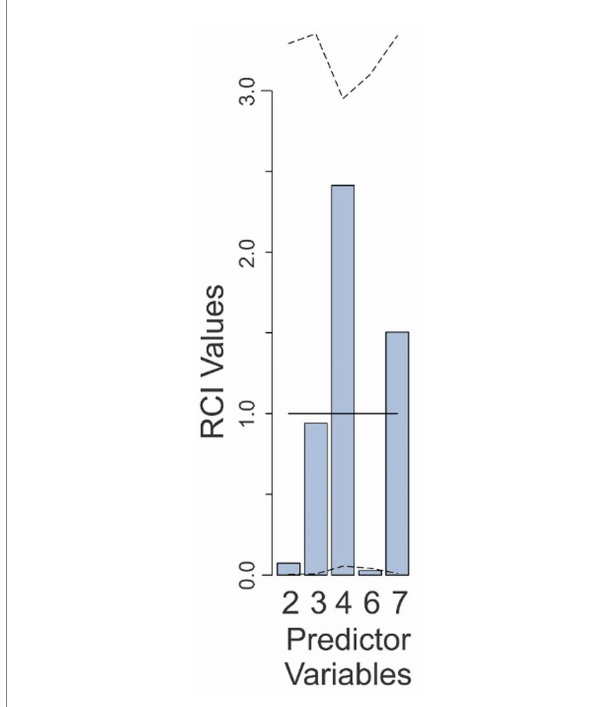
FIGURE 2 Relative contributions of various predictors to the fit of the Final Model in Experiment 1. The predictor variables are those that are retained in the Final Model and are numbered as in Table 1. The solid line denotes the expected contributions of the various predictors. The dashed lines denote the upper and lower 95% confidence intervals (uncorrected), empirically determined from the data. See text for